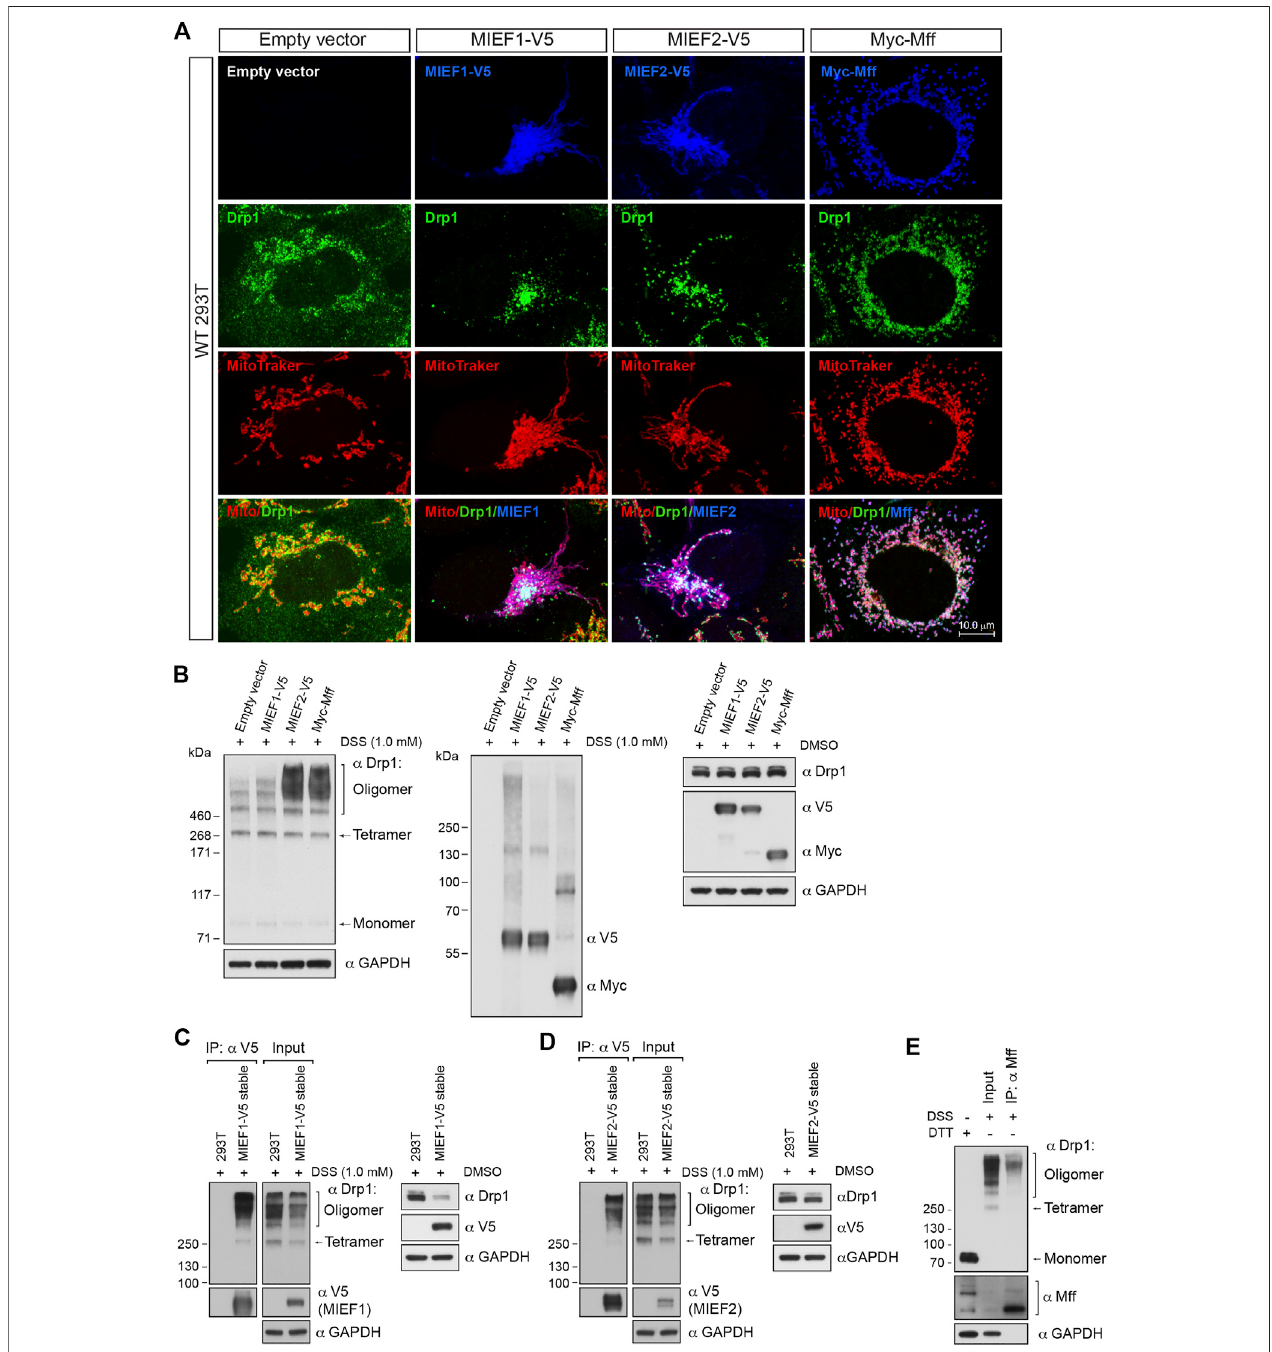
FIGURE 2 | Receptor-mediated mitochondrial recruitment of Drp1 enhances Drp1 oligomerization. (A) Confocal images of mitochondrial morphology and Drp1 distributioninWT293Tcellstransfectedwithemptyvector,MIEF1-V5,MIEF2-V5,orMyc-Mff.At16 hpost-transfection,cellswerestainedwithMitoTracker(red)before fi xation, followed by immunostaining with anti-Drp1 (green) and anti-V5 or anti-Myc (blue) antibodies (white color indicates co-localization of mitochondria, Drp1 and the respective receptor protein). (B) The oligomeric states of Drp1 in WT 293T cells transfected with empty vector, MIEF1-V5, MIEF2-V5, or Myc-Mff. 293T cells were transfected with indicated plasmids for 18 h and incubated with freshly-prepared 1 mM DSS or DMSO (control) for 3 h at room temperature, followed by Western blotting with indicated antibodies. (C,D) MIEF1/2 interact with a wider-range of Drp1 assembly subunits. WT 293T cells and 293T cell lines stably expressing MIEF1-V5 (C) or MIEF2-V5 (D) were treated with freshly-prepared 1 mM DSS or DMSO (control) for 3 h at room temperature and subjected to co-IP with anti-V5 beads. The immunoprecipitates were analyzed by immunoblotting with indicated antibodies. (E) Mff preferentially binds to higher order oligomers of Drp1. WT 293T cells were treated with freshly-prepared 1 mM DSS for 3 h at room temperature and subjected to co-IP. Cell lysates were incubated with Dynabeads ™ protein G beads pre- conjugated with 2 μ g anti-Mff antibody overnight at 4 ° C. The bead-binding proteins were dissolved and analyzed by Western blotting with indicated antibodies.